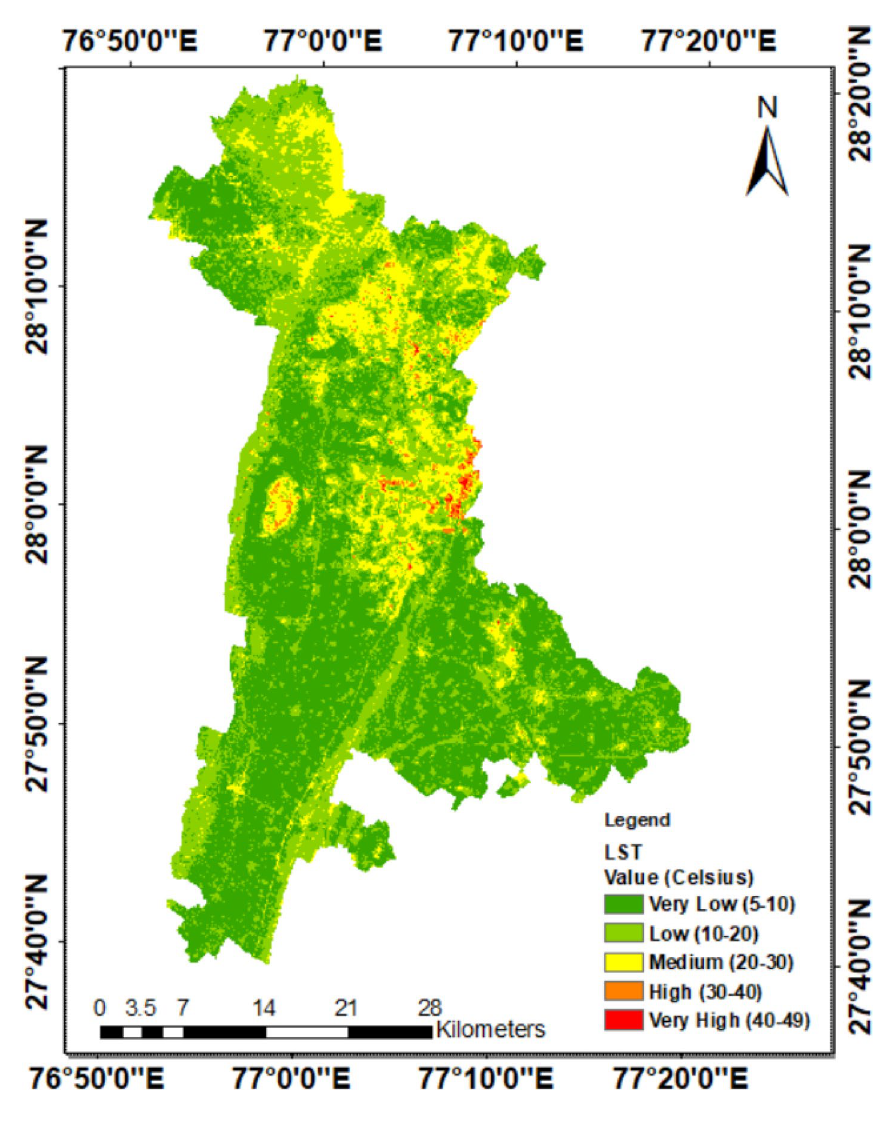
Fig. 10 Land surface tempera- ture map of study